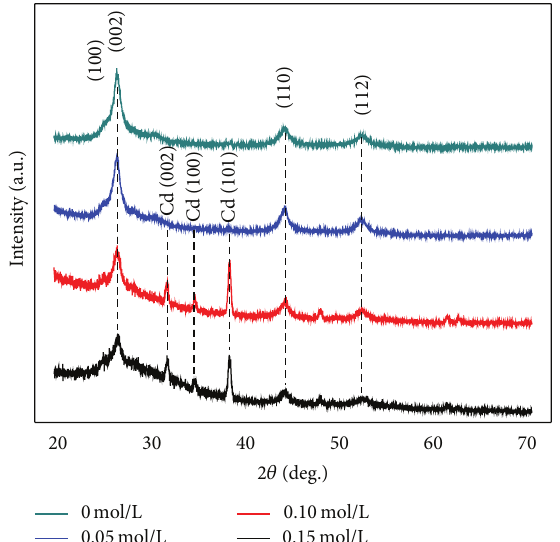
Figure 1: XRD patterns of CdS/Si-NPA with the buffer agent concentration of 0mol L −1 , 0.05 molL −1 , 0.10 molL −1 , and 0.15mol L −1 .